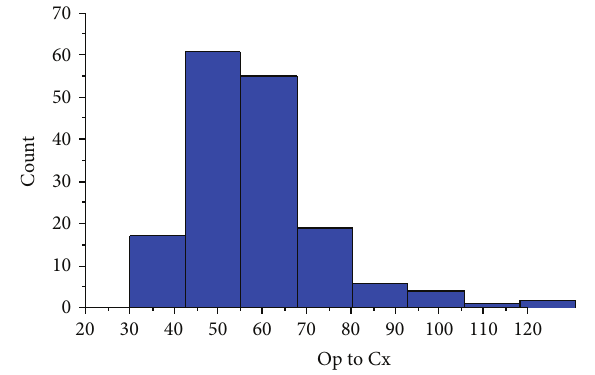
Figure 1: Distribution of time intervals from operation to com- mencement of chemotherapy (for inclusion in online publication